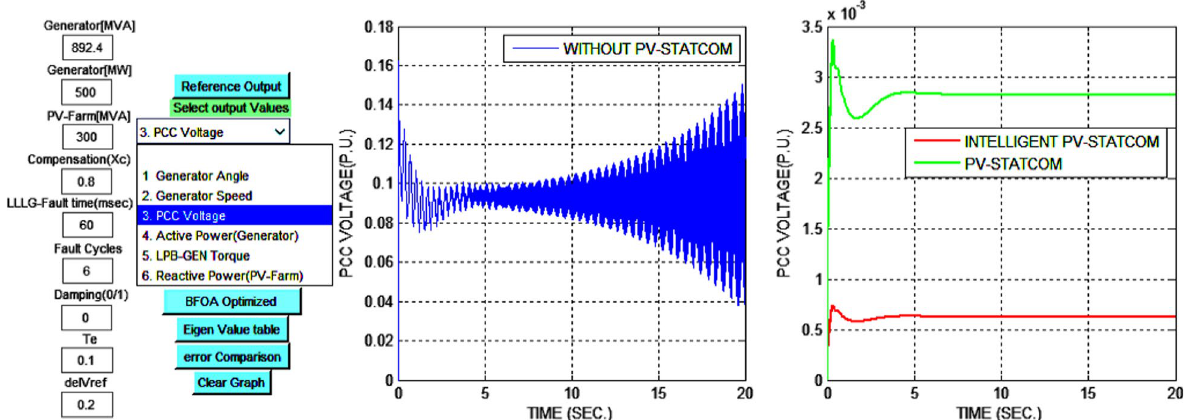
Fig. 12 Coupling voltage deviation (ΔV)